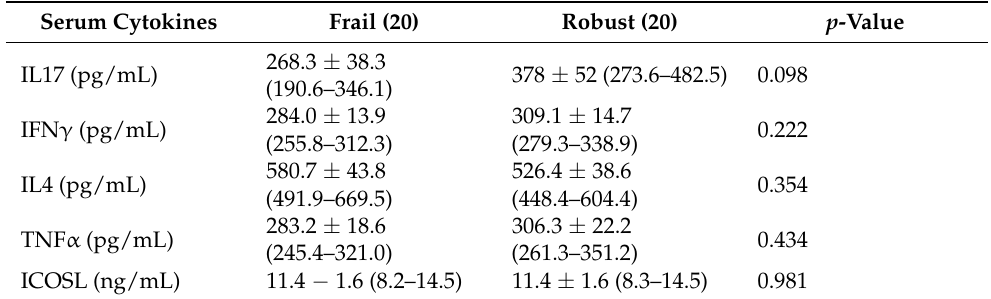
Table 3. Serum cytokines in frail and robust older subjects. Mean and SD values with CIs are shown. p -values were calculated by one-way